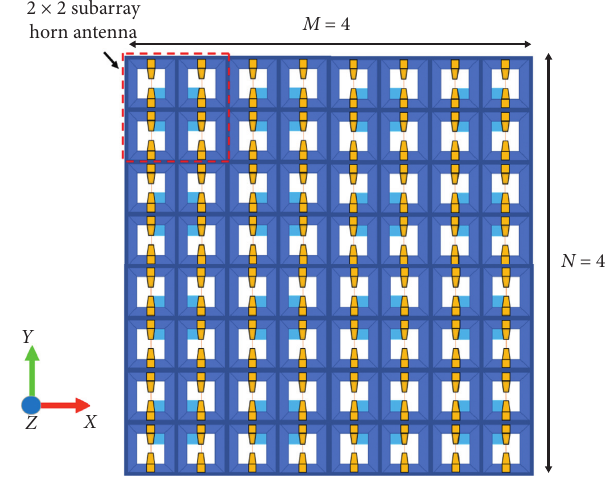
Figure 10: Top view of a 4 × 4 horn-based array antenna as presented in